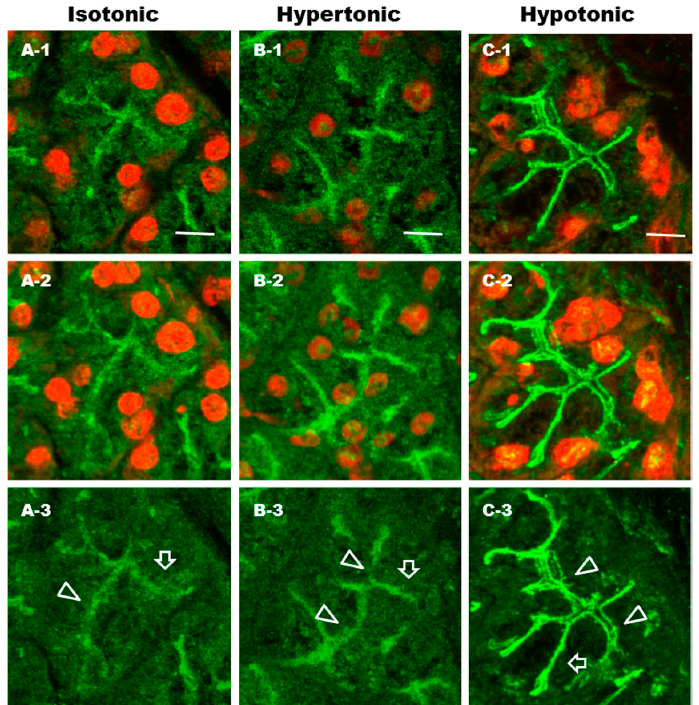
Figure 7. Immunohistochemical analysis of AQP5 distribution in rat parotid acinar cells under isotonic, hypertonic and hypotonic conditions. Parotid gland tissue sections were incubated for 10 min at 37 °C in isotonic ( A ), hypertonic ( B ) and hypotonic ( C ) solutions. Tissue sections were fixed in ethanol followed by incubation with anti-AQP5 antibody. Secondary antibody coupled to Alexa-488 was used to visualize AQP5. PI was used to stain nuclei. One section is presented in each single image ( − 1). Sixteen consecutive images produced by a confocal microscope were projected to generate a single image ( − 2). To get clear visualization of the AQP5 localization in acinar cells, the 568 nm laser was turned o ff ( − 3). Arrow heads and arrows indicate APM and LPM, respectively. Scale bars: 10 µm.